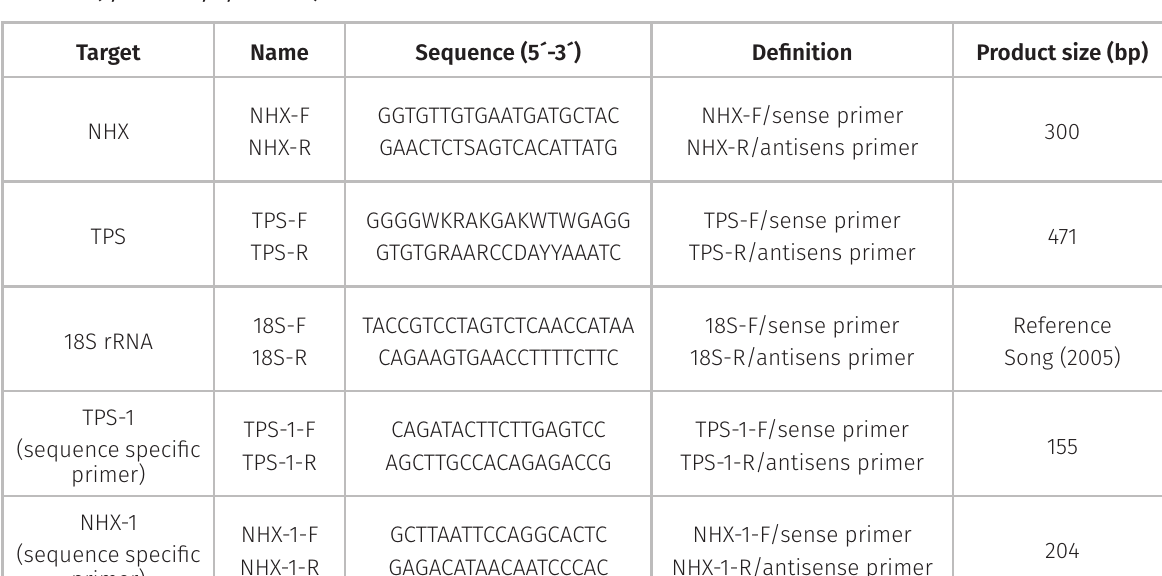
Table II. The list of the designed degenerate primers, control and housekeeping gene primers employed in this research (F, forward, R,